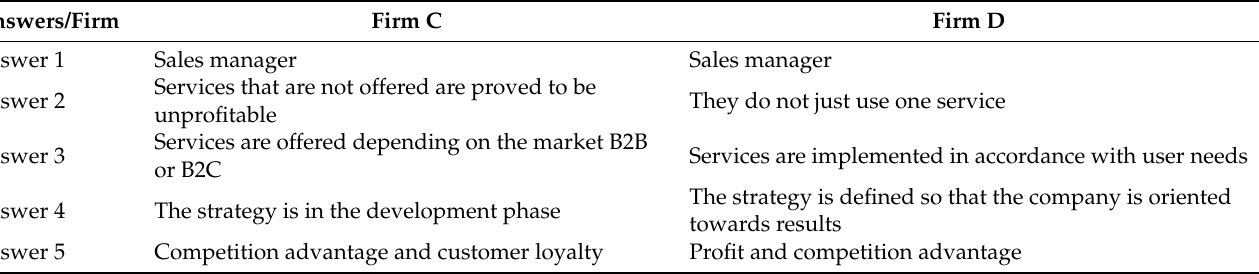
Table 7. Interviews with representatives from medium-tech firms.